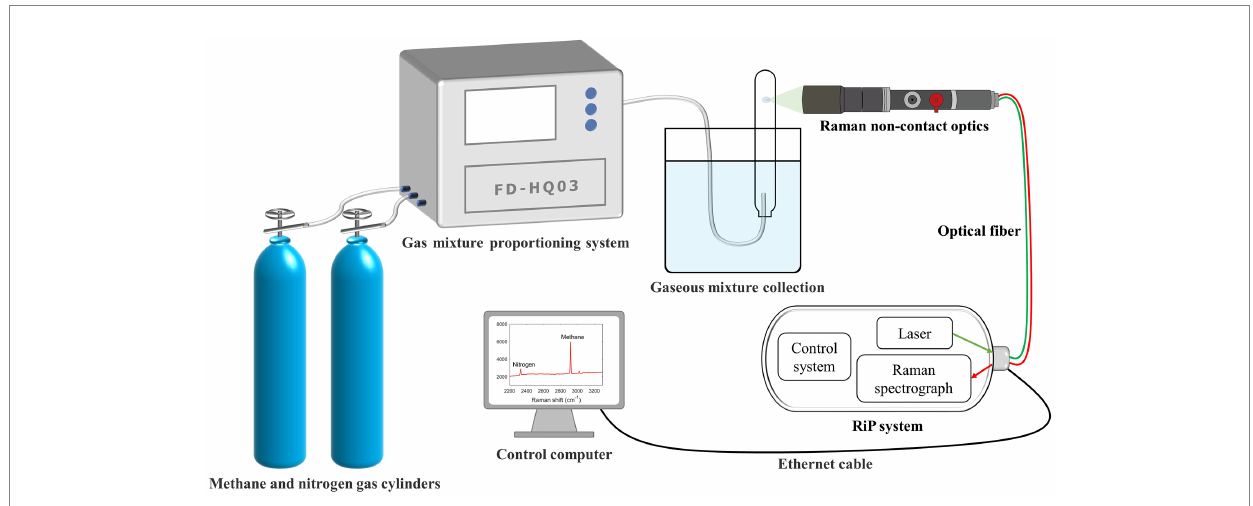
FIGURE 1 Schematic of the experimental system for establishing the calibration curve. The system is equipped with gas-mixing, RiP, and Raman non-contact optical